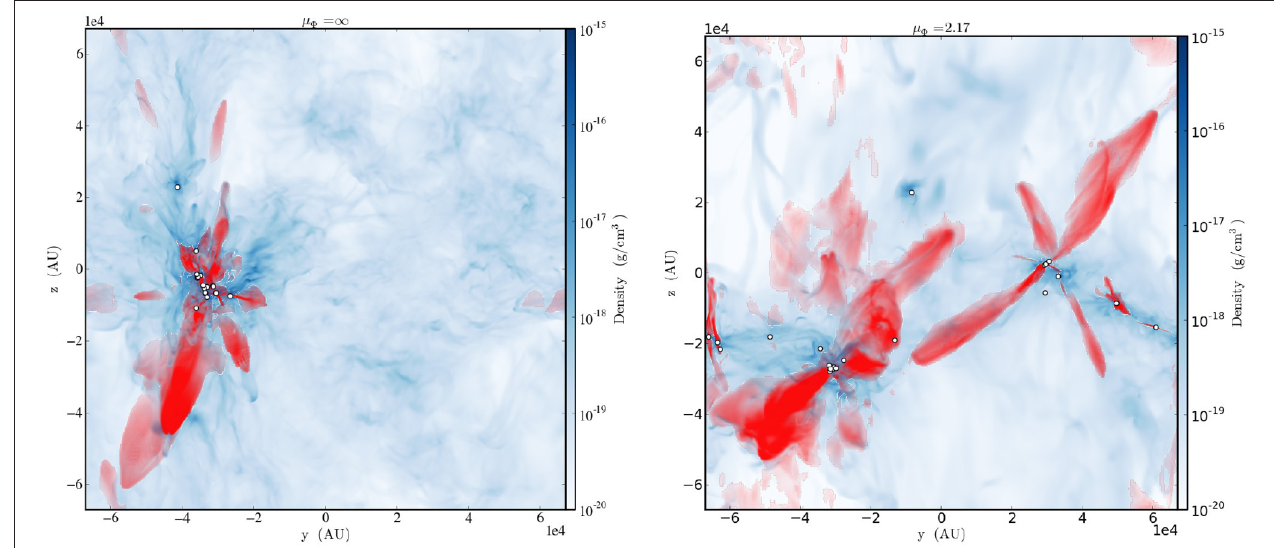
FIGURE 3 | Results from simulations of star cluster formation including outflows and radiative heating by Cunningham et al. (2018), comparing a case without magnetic fields ( left , mass to magnetic critical mass ratio µ 8 ) to an otherwise-identical simulation with a strong magnetic field ( right , mass to magnetic critical = ∞ mass ratio µ 8 2.17). Blue color shows volume-weighted mean density projected along each line of sight. Red color indicates the presence of gas moving with = velocity greater than twice the RMS speed in the simulation domain, with the opacity becoming complete at fives times the RMS speed; thus the red color mostly traces outflows or gas entrained by them. White circles indicate the positions of protostars. Note how the simulation without magnetic fields has most of the mass collapsed into a single dense clump, with outflows poking small holes but not ejecting much mass. The strongly magnetized run has a more distributed morphology, and outflows are more effective at preventing the build-up of dense